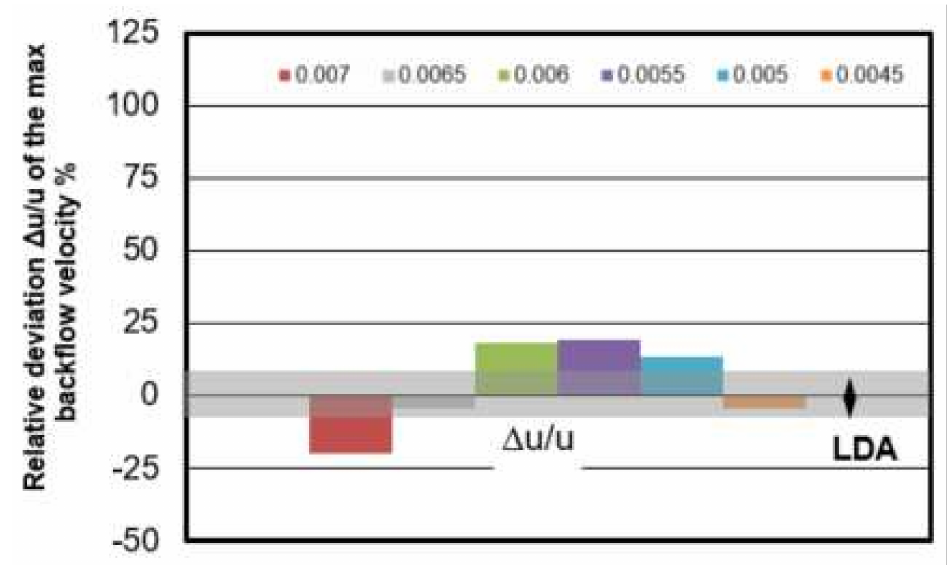
Figure 6. Relative deviation ∆ u/u of the maximum backflow velocity between CFD simulation and measurements.